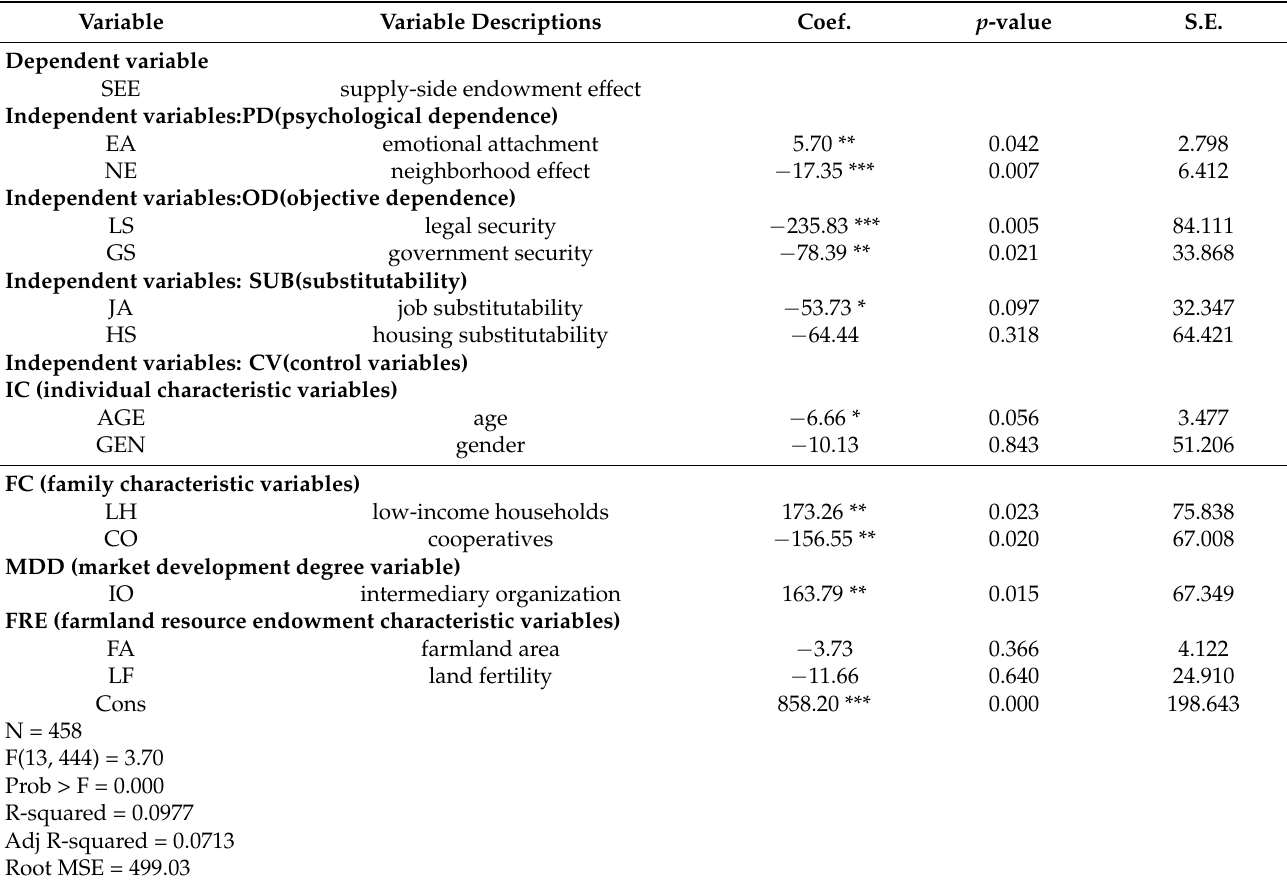
Table 5. Estimation results of the influence of the supply-side endowment effect based on the multiple regression